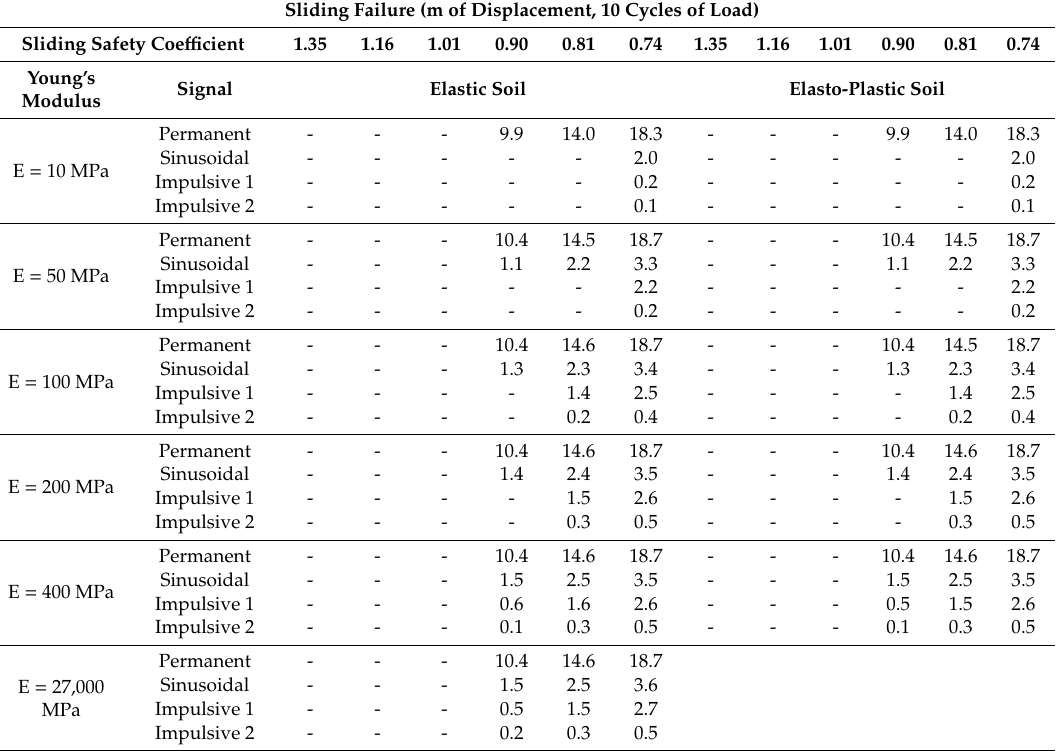
Figure 20. Maximum deformation as a function of the bearing capacity safety coefficient (BCSC) and Young’s modulus of the soil, assuming elastic soil. ( A ) Permanent; ( B ) Sinusoidal; ( C ) Impulsive 1; ( D ) Impulsive 2. Table 6. Crown wall sliding in simulations under load state